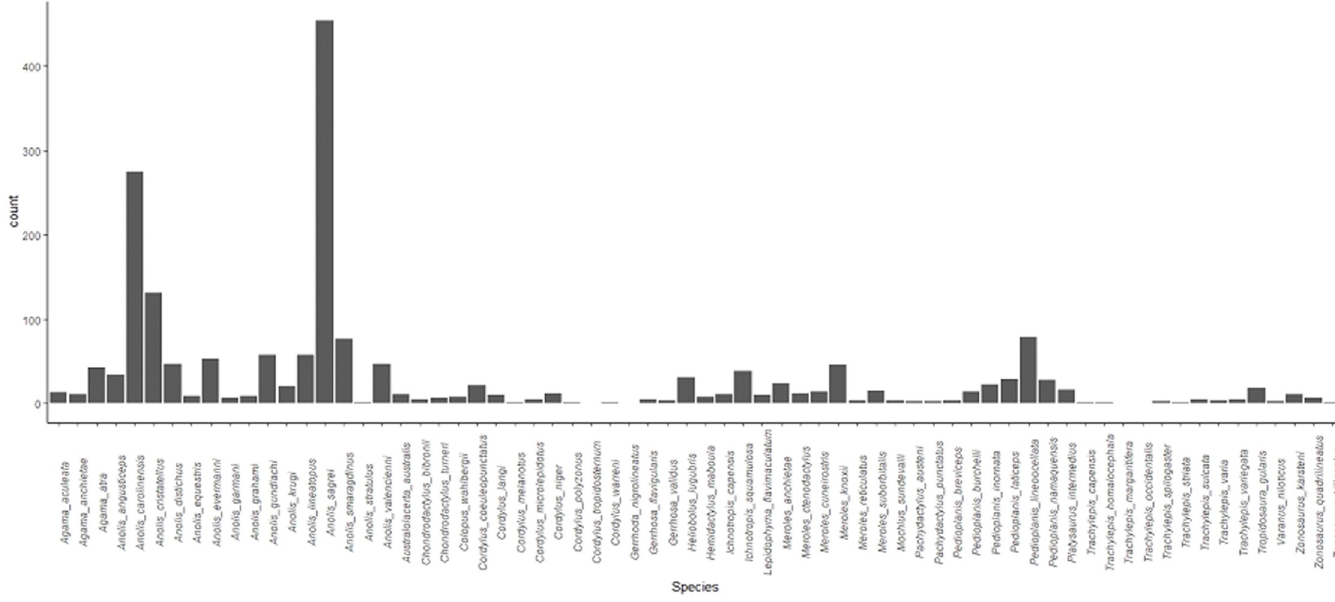
Fig 1. Species names and sample size for each of the 68 taxa comprising the training and verification dataset.